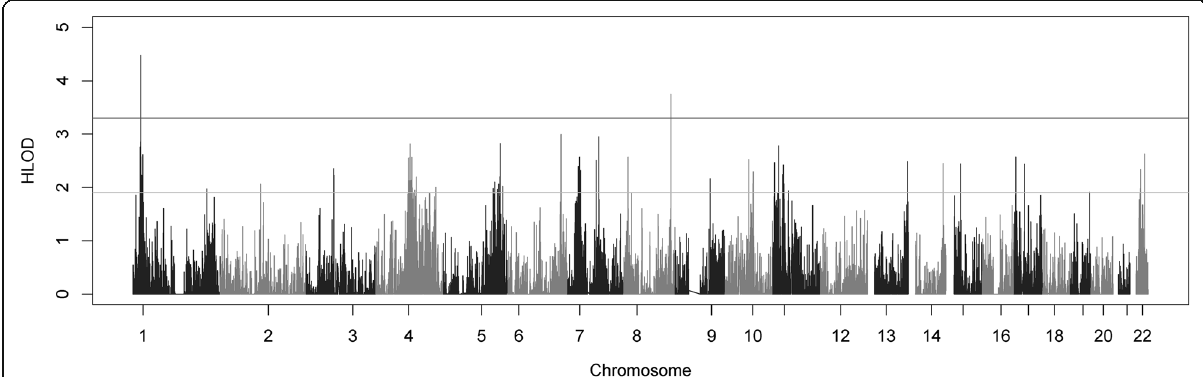
Fig. 1 Genome-wide plot of two-point heterogeneity LOD (HLOD) scores across the 64 Ashkenazi families. The lines at 1.9 and 3.3 represent the respective suggestive and significant thresholds recommended by Lander and